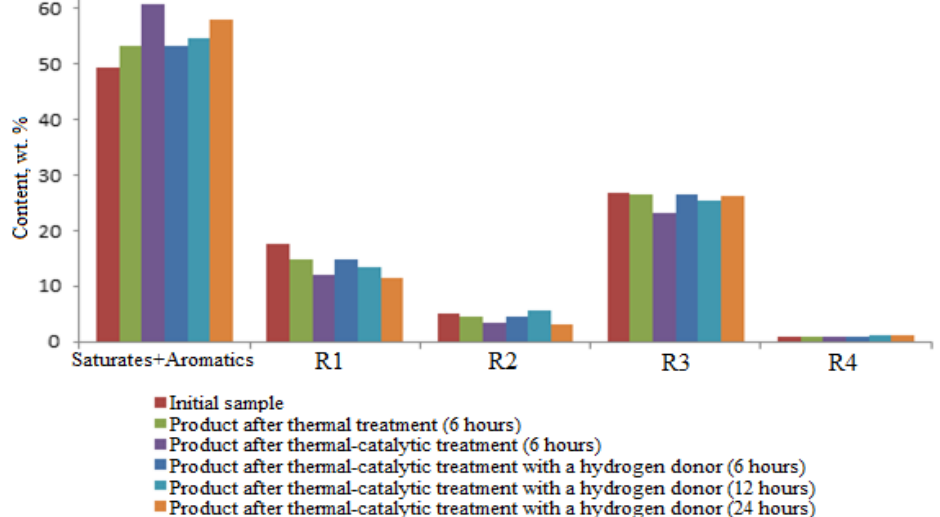
Figure 1. Fractional composition of oil resins from Ashalcha field.